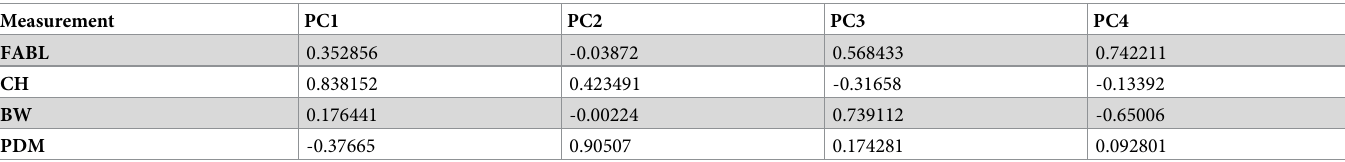
Table 3. Coefficients of the PCA analysis run on the deinonychosaurian teeth dataset published by Larson and Currie [30].